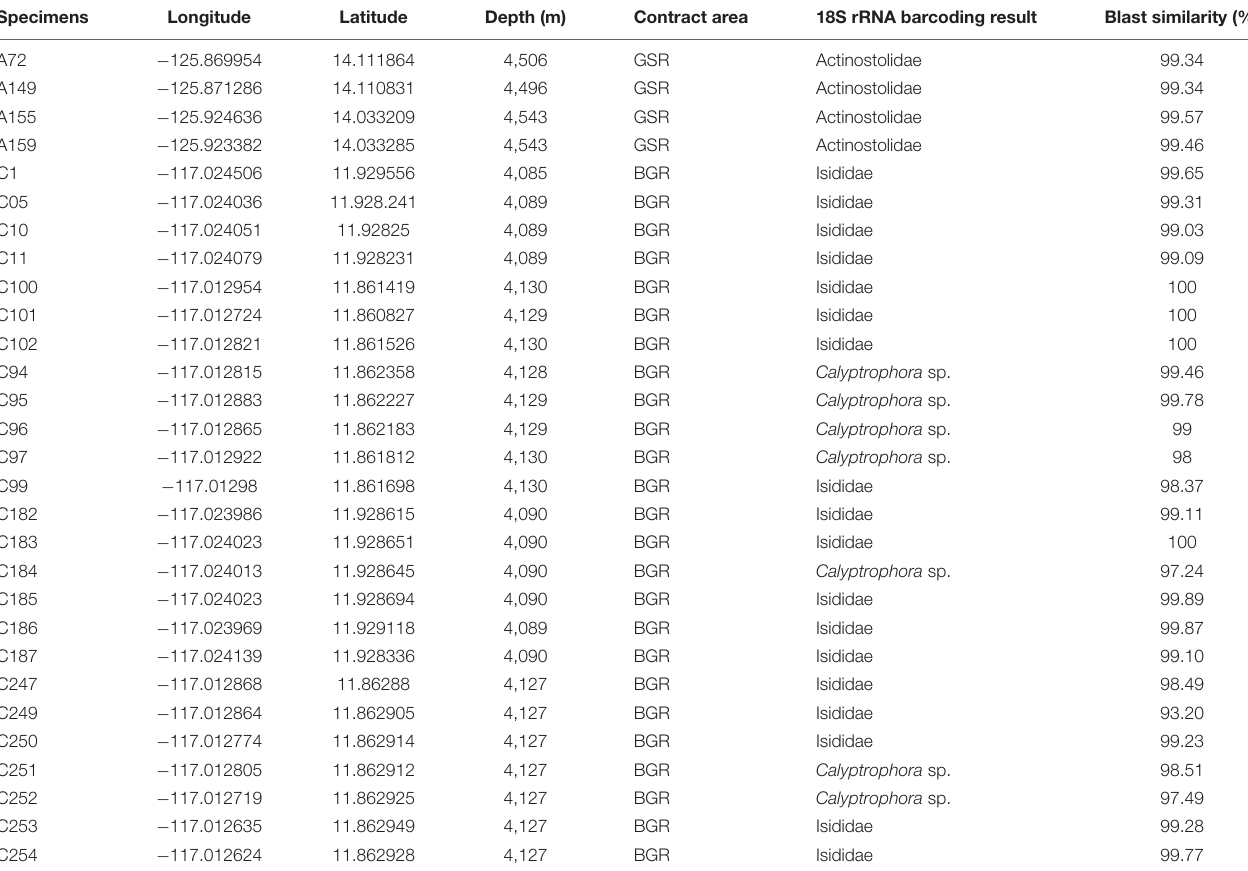
TABLE 1 | Summary of specimens’ taxonomy, collection sites, and